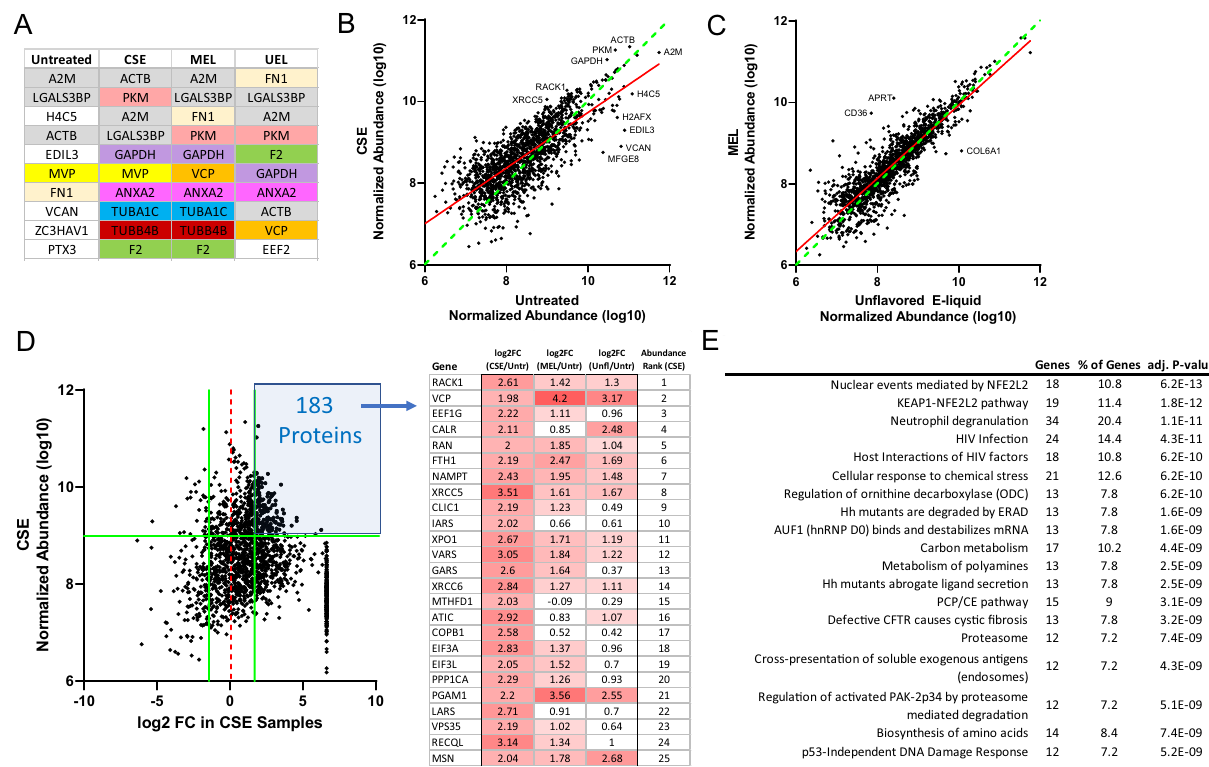
Figure 3. Proteomic analyses of smoking- and E-liquid-induced BCEVs. ( A ) The top 10 proteins in EVs from the indicated TCCSUP cell treatment groups, ordered based on relative abundance. (B, C) Comparison of the relative abundance of all proteins detected in both CSE and untreated TCCSUP cell EV samples ( B ) and UEL and MEL EV samples ( C ). Data represent log10-transformed normalized abundance values. ( D ) Approach to the selection of the top enriched proteins in EVs derived from CSE-treated TCCSUP cells (log 2 FC > 1.5, normalized abundance > 10 9 ). The top enriched genes are shown ordered based on their overall abundance in CSE-EVs, with corresponding fold-change values for these proteins in the EVs from each of the three indicated TCCSUP EV groups relative to EVs from untreated TCCSUP cells. ( E ) KEGG and Reactome pathway enrichment analysis results for the 183 proteins highlighted in ( D ), performed with the DAVID